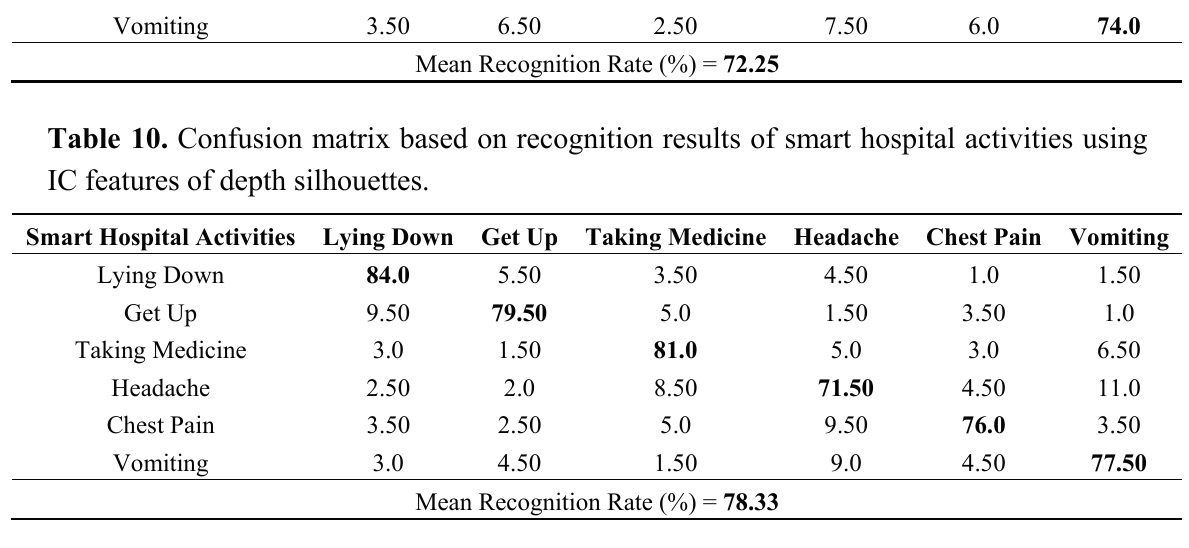
Table 11. Confusion matrix based on recognition results of smart hospital activities using the proposed motion features of depth